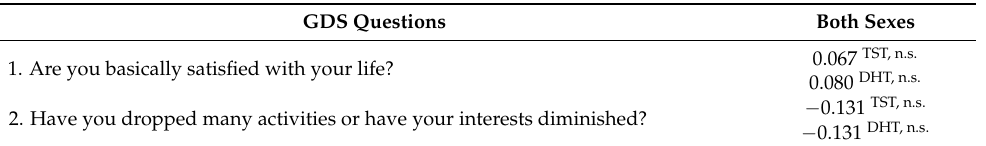
Table 5. Point-biserial correlation coefficients for the answers suggesting depression to singular questions of the GDS questionnaire and the plasma levels of testosterone and